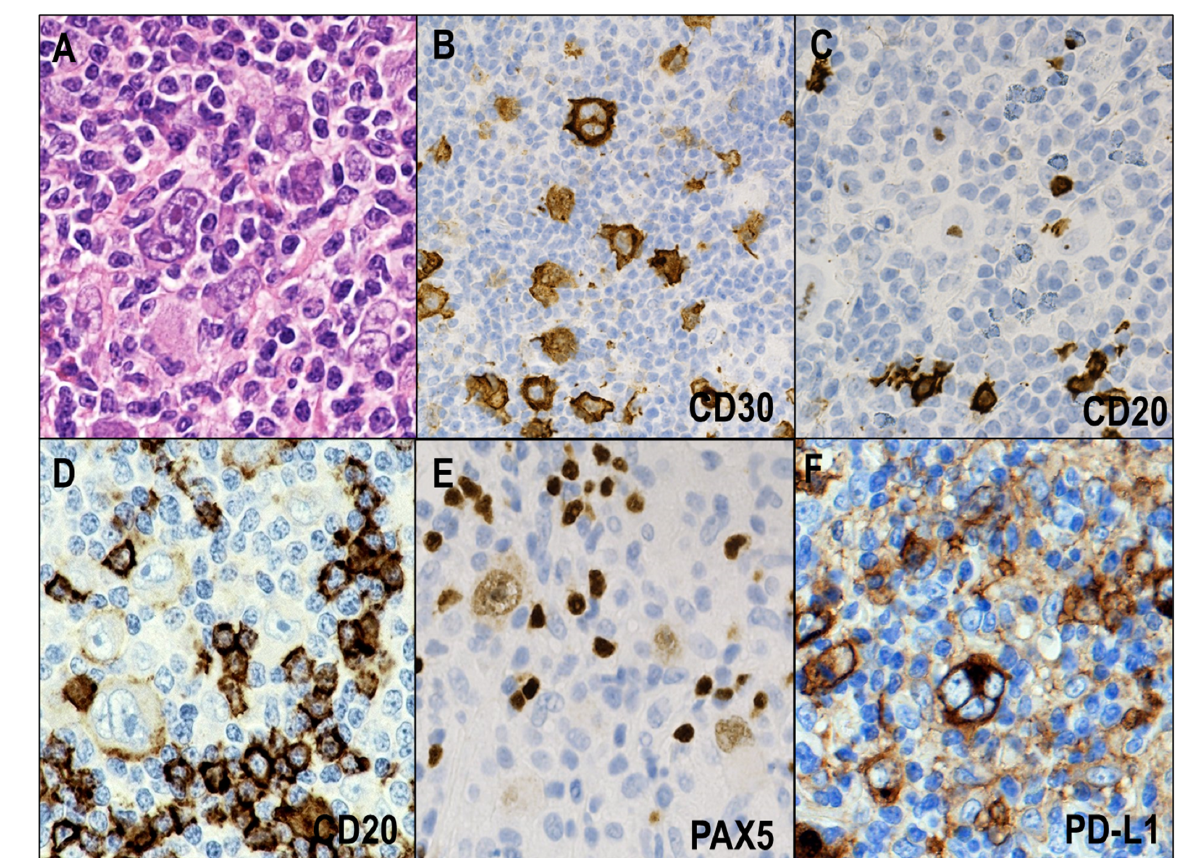
Figure 1. Histological and immunohistochemical features of classic Hodgkin lymphoma (CHL). ( A ) CHL is histologically composed of Hodgkin and Reed–Sternberg (HRS) cells and abundant reactive bystander cells (HE × 400). ( B ) HRS cells are universally positive for CD30 ( × 400). ( C , D ) HRS cells are negative or weakly positive for CD20 ( × 400). ( E ) HRS cells typically show weak expression of PAX5 ( × 400). ( F ) HRS cells are highly associated with PD-L1 expression ( × 400).